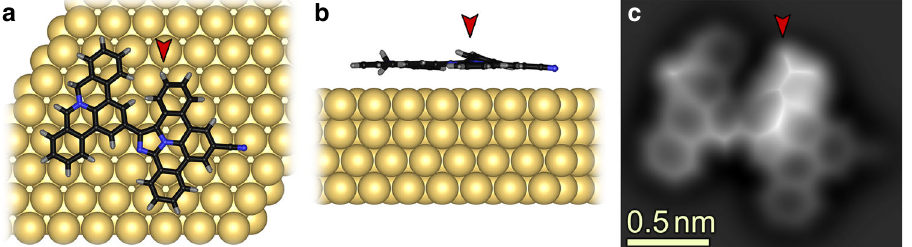
Fig. 3 Theoretical modeling of a dimer on Au(111). ( a ) Top and ( b ) side views of the DFT-relaxed geometry of a dimer (as shown in Fig. 2h). One of the carbon atoms adjacent to the N-atom of the phenanthridinium moiety has two hydrogen atoms, pointing upwards and downwards, respectively. Furthermore, one of the phenyl rings of the right monomer (marked with red arrows in a – c ) is bending upwards due to steric repulsions between the monomer units. c The simulated AFM image of the dimer shows a bright (more repulsive) contrast for the protruding hydrogen atom and the upwards- bending phenyl ring, in agreement with the contrast observed in the experimental image (Fig. 2e).